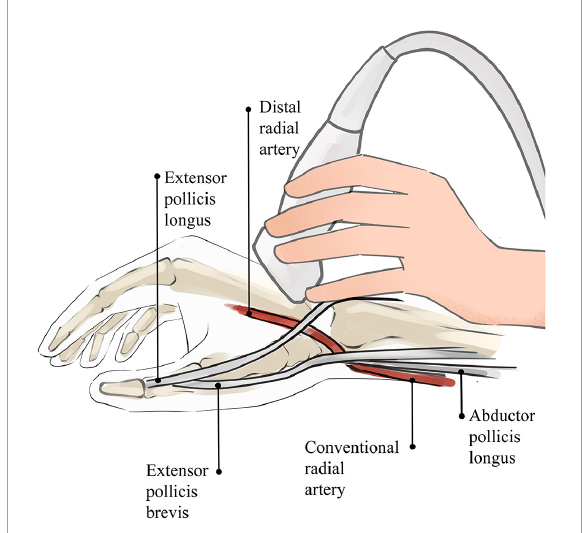
FIGURE2 Sketch of ultrasound technique of AS. The operator’s little finger touches the patient’s forearm as a support point, which prevents the blood vessel from being affected by external forces.